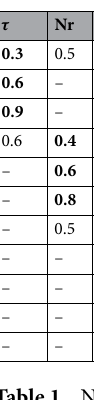
Table 1. Nusselt number (rate of heat transfer) for variation of several parameters. The consecutive bold values of a parameter exhibit the variation in that